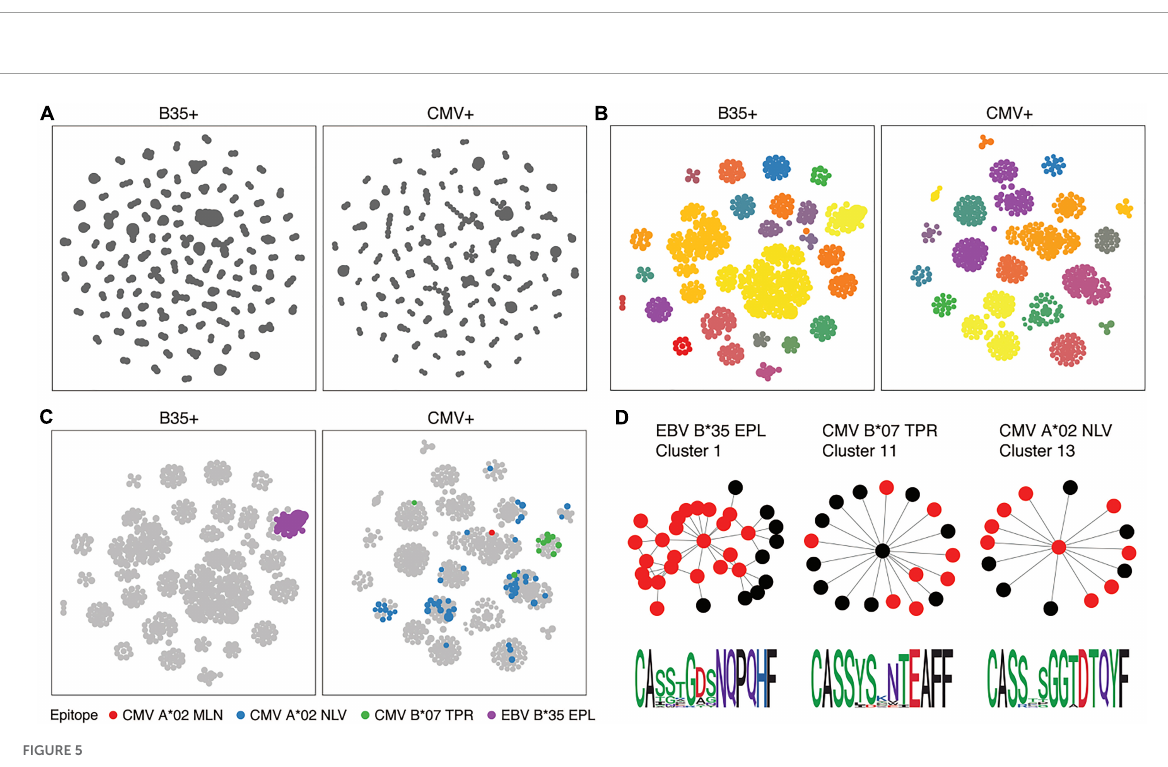
FIGURE4 Dimensionality reduction (144). An example of dimensionality reduction use to display the results of unsupervised clustering. Heatmaps (C) display the representation of input features in each cluster. While TSNE graphs allow visualization of the distribution of clusters or cell types (A) , input feature (B) , and detection of differences in cluster frequency between sample types (D) .